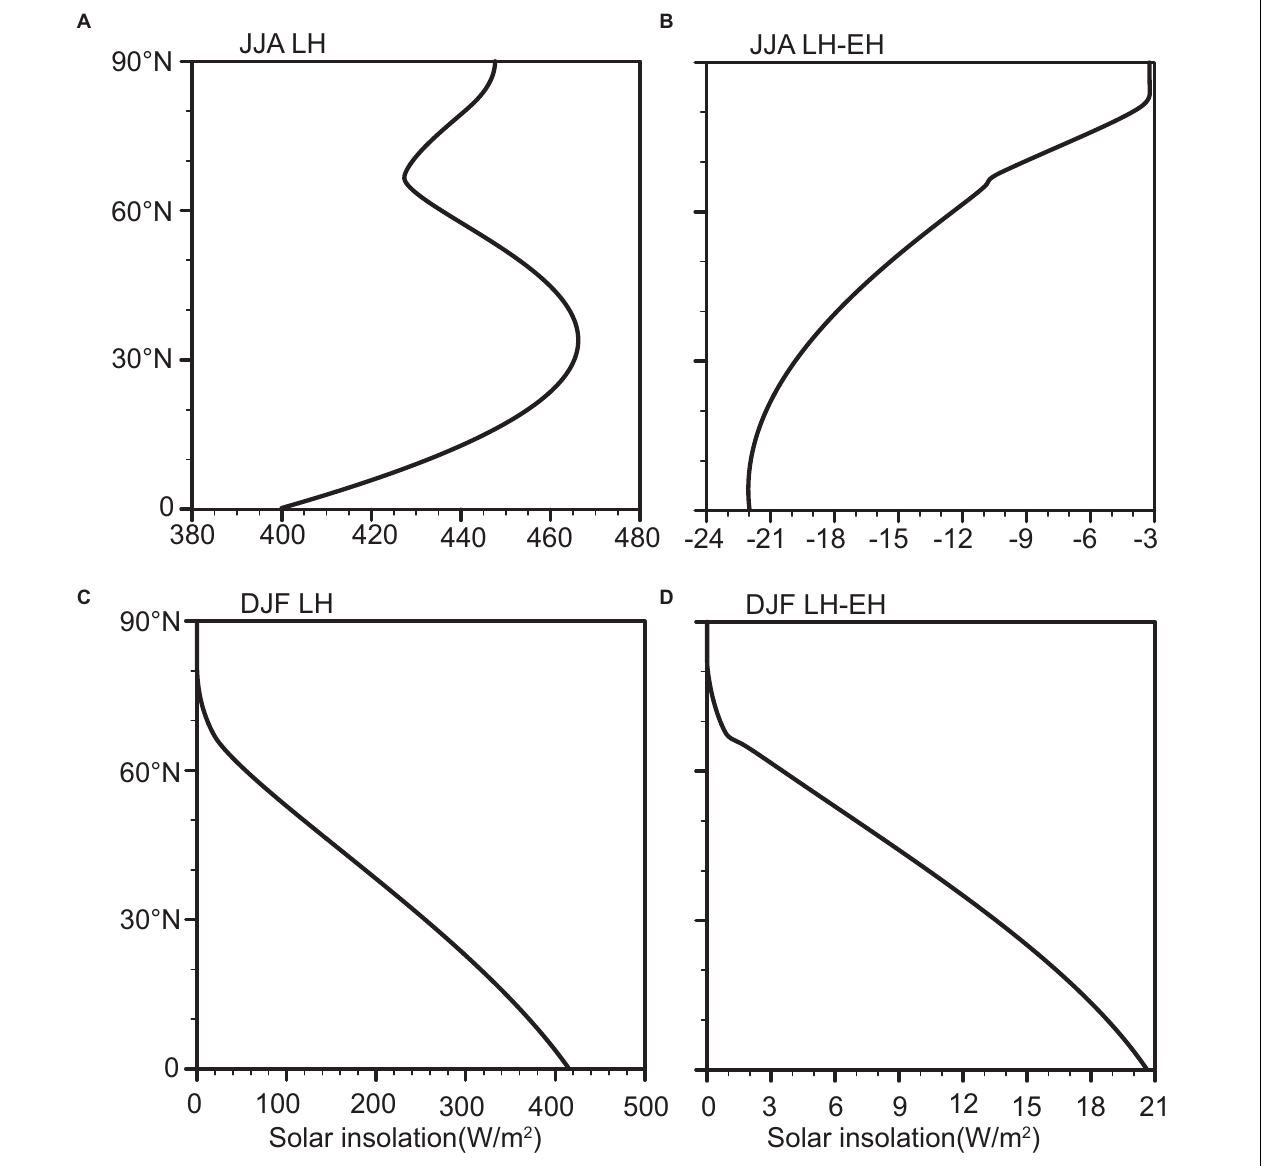
FIGURE 11 | Zonal mean profiles of solar insolation. Summer and winter solar insolation in LH (A,C) and the LH-minus-EH difference (B,D) .